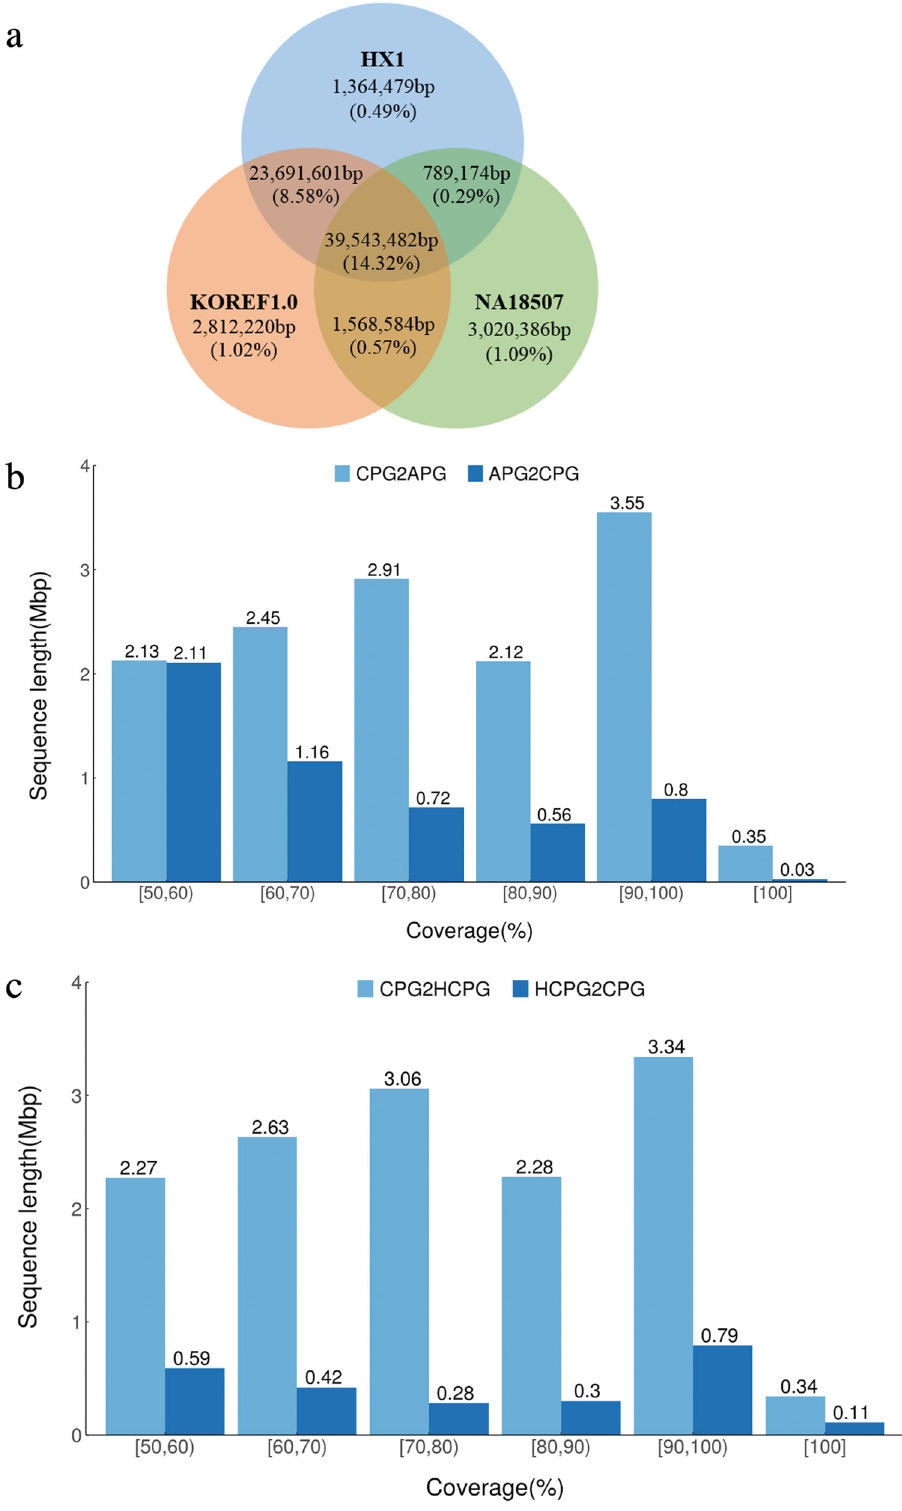
Fig. 6 Alignment of CPG to other human genomes. a Venn diagram of alignment of CPG to three human genomes, HX1 (Chinese), KOREF1.0 (Korean), and NA18507 (African). The alignments were based on at least 90% identity. b The length distribution of novel sequences from APG and CPG that can be aligned with each other with ≥ 90% identity. CPG2APG: CPG aligned to APG. APG2CPG: APG aligned to CPG. c The length distribution of novel sequences from CPG and HCPG that can be aligned with each other with ≥ 90% identity. CPG2HCPG: CPG aligned to HCPG. HCPG2CPG: HCPG aligned to